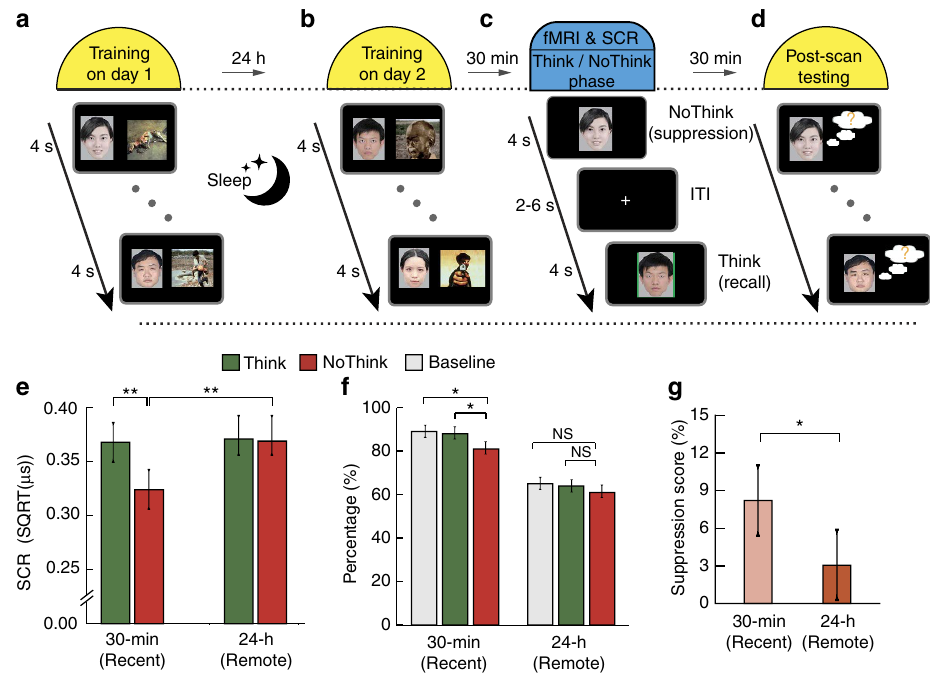
Figure 1 | Experimental design and results from physiology and behaviour. ( a , b ) The experiment consisted of three phases, including acquisition, Think/NoThink and post-scan memory test. During the acquisition phase outside the scanner, participants performed two training sessions on day 1 and day